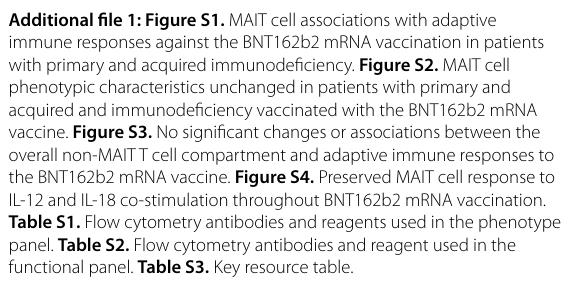
panel. Table S2. Flow cytometry antibodies and reagent used in the functional panel. Table S3. Key resource